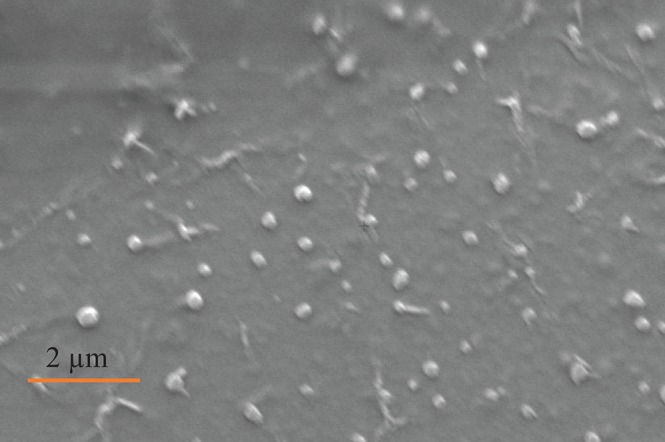
Image of EVs obtained by SEM from participant (n = 1), Electron high tension = 5.00 kV, working distance = 20.9 mm, detector = secondary electron, magnification = 8.70 K X, vacuum mode = high vacuum, height = 9.851 μm.